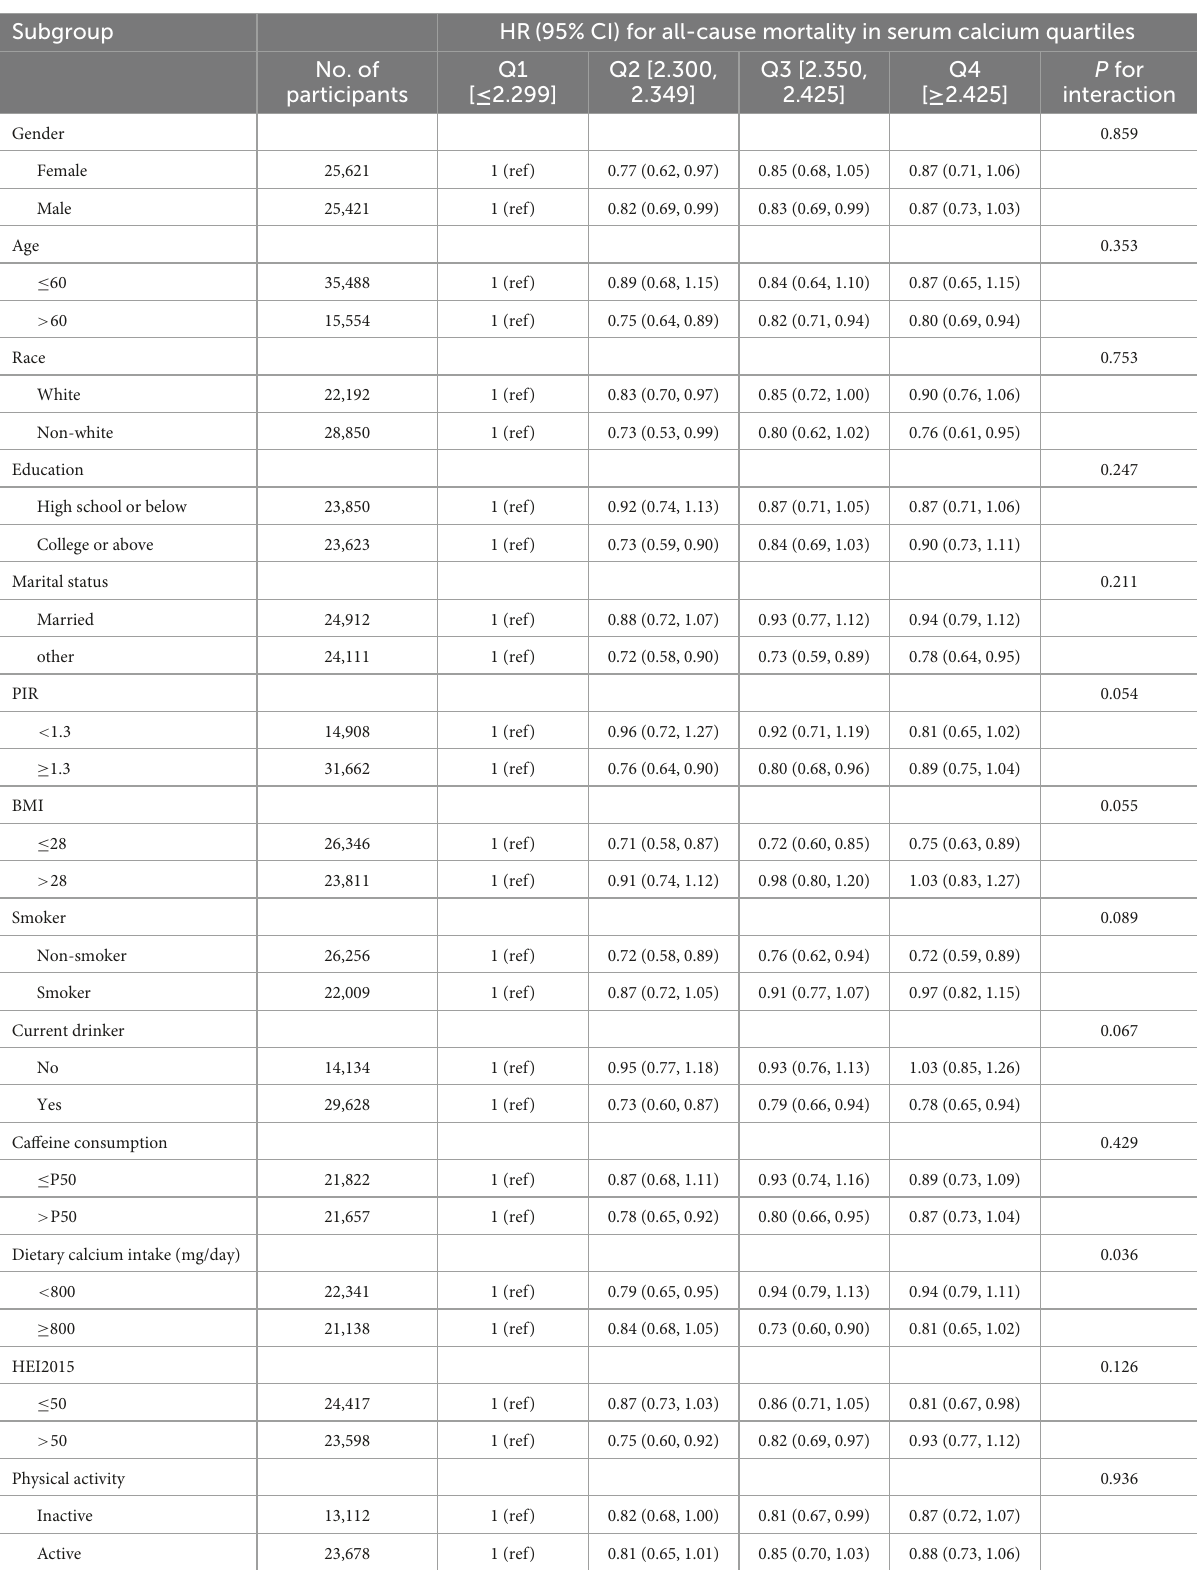
TABLE 3 Subgroup analyses of the associations of serum calcium quartiles with all-cause mortality.